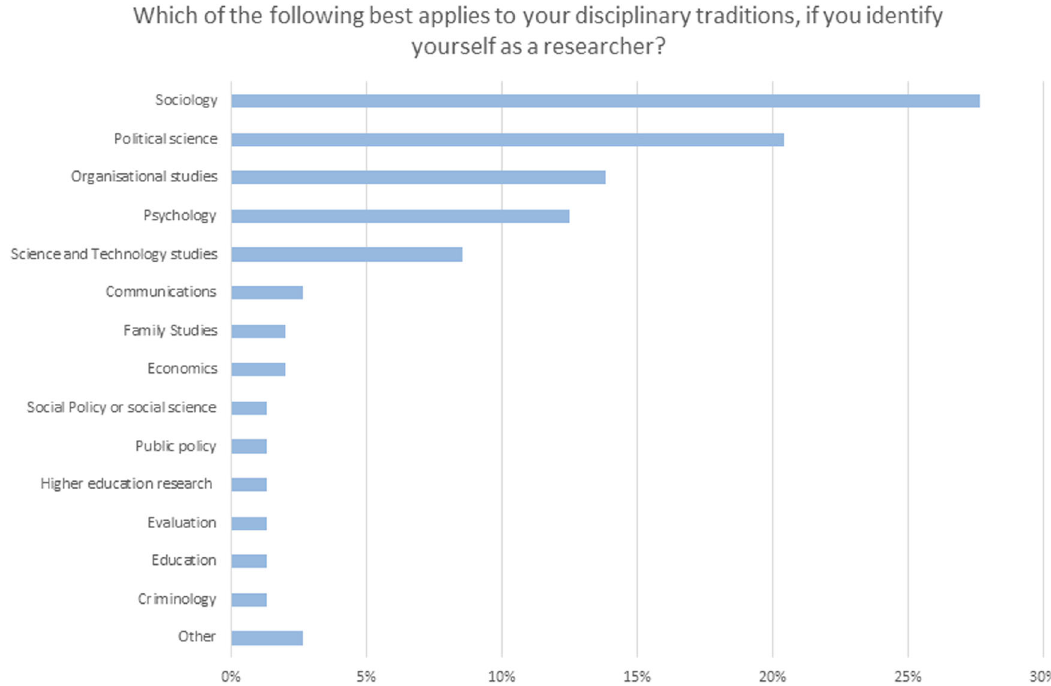
Fig. 3 Disciplinary traditions of respondents. Survey respondents ’ indicated their primary disciplinary traditions. Bars indicate the percentage of respondents indicating each